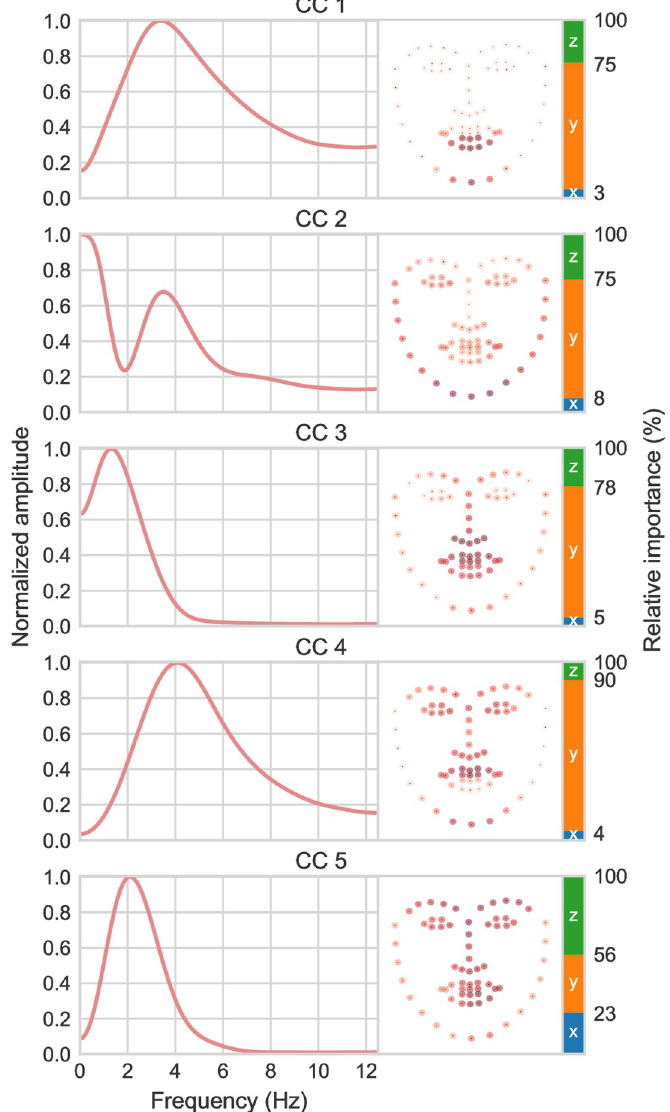
Fig 2. CCA results for the LRS3 dataset. Left : CCA-derived temporal modulation filters for the first 5 significant canonical components (CCs). Right : corresponding facial landmark loadings. Darker red indicates higher weights. The 3D landmarks are shown in 2D projection, and the colorbar indicates the relative contribution of the x (blue), y (orange), and z (green)